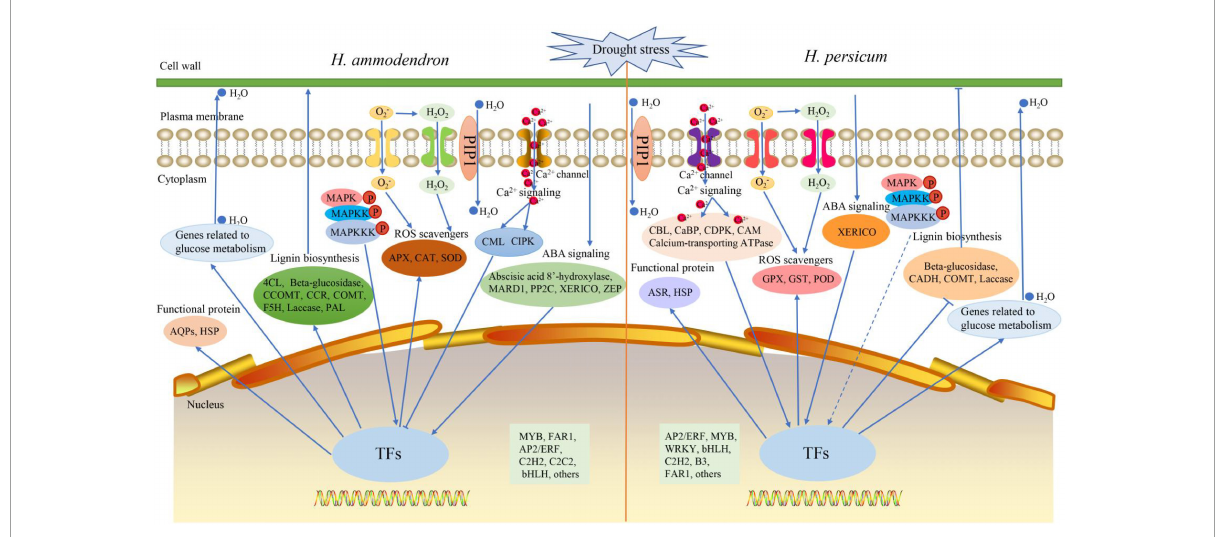
FIGURE9 A hypothetical model of drought tolerance mechanism for H. ammodendron and H. persicum . Arrows indicate positive regulation, lines ending in bars indicate negative regulation, dashed arrows indicate neither up regulation nor down regulation.